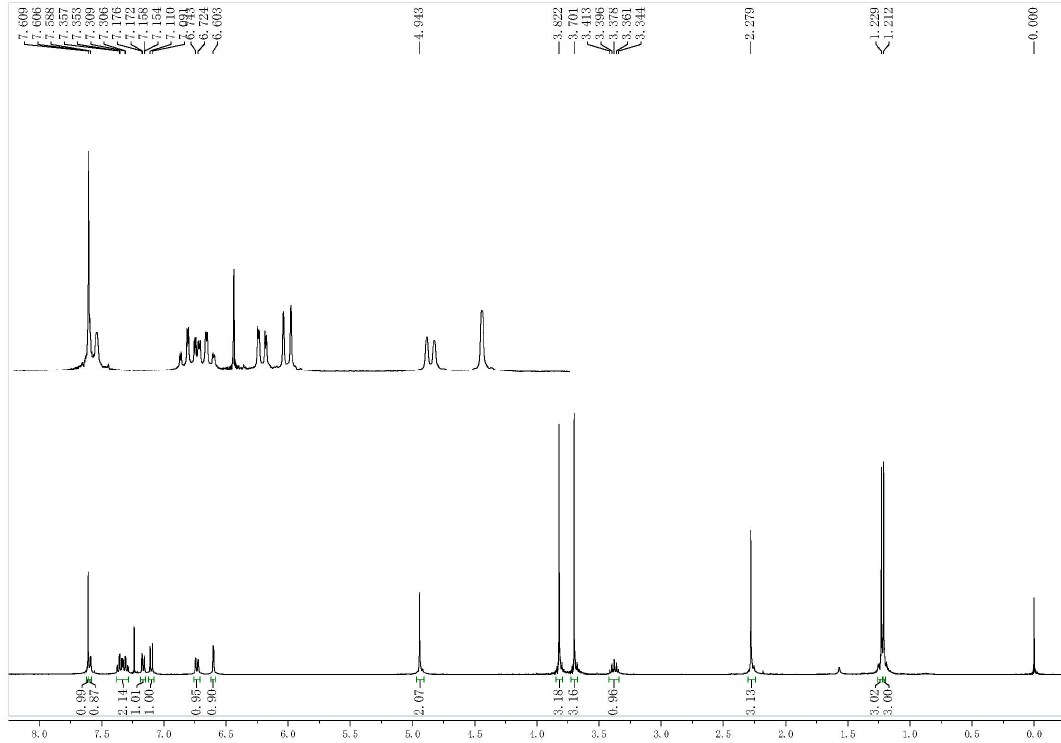
Figure 3. Representative 1 H-NMR spectrum of compound II-1 .